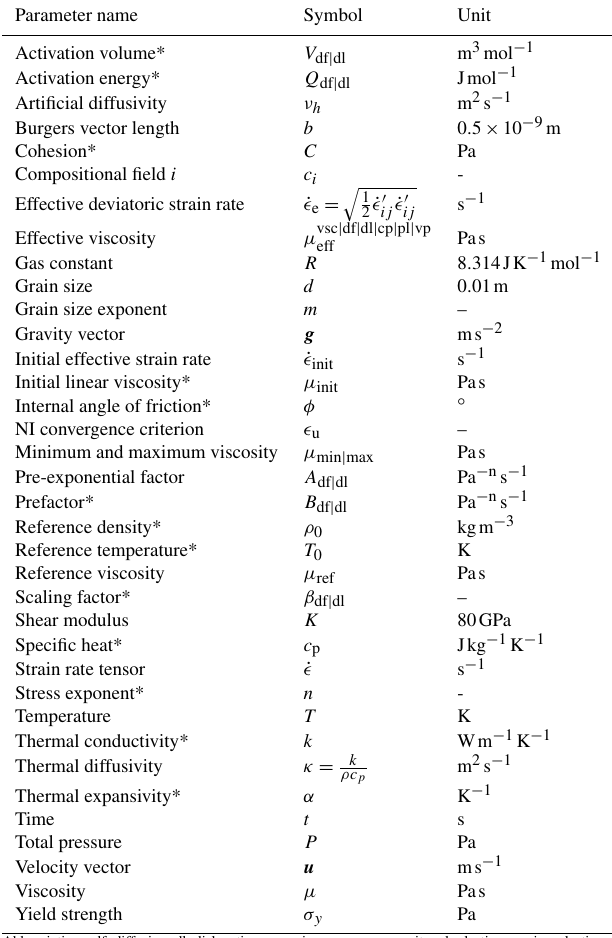
Table 1. Definition of